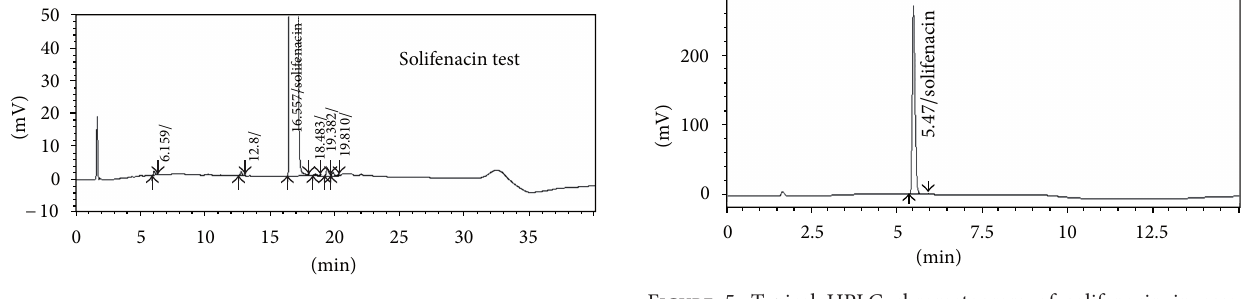
F 3: Typical HPLC chromatogram of pure solifenacin succi- nate.